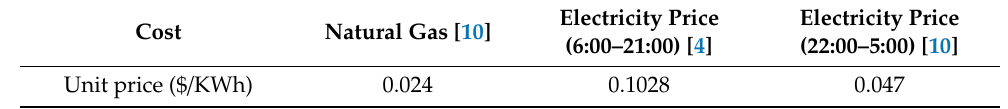
Table 3. Time-of-use electricity price and natural gas price.